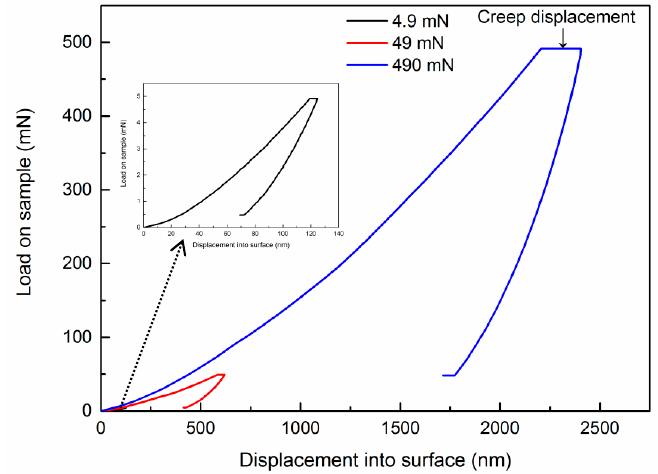
Figure 2. Load-displacement curves of nanostructured 8YSZ coatings at di ff erent loads with 10 s holding